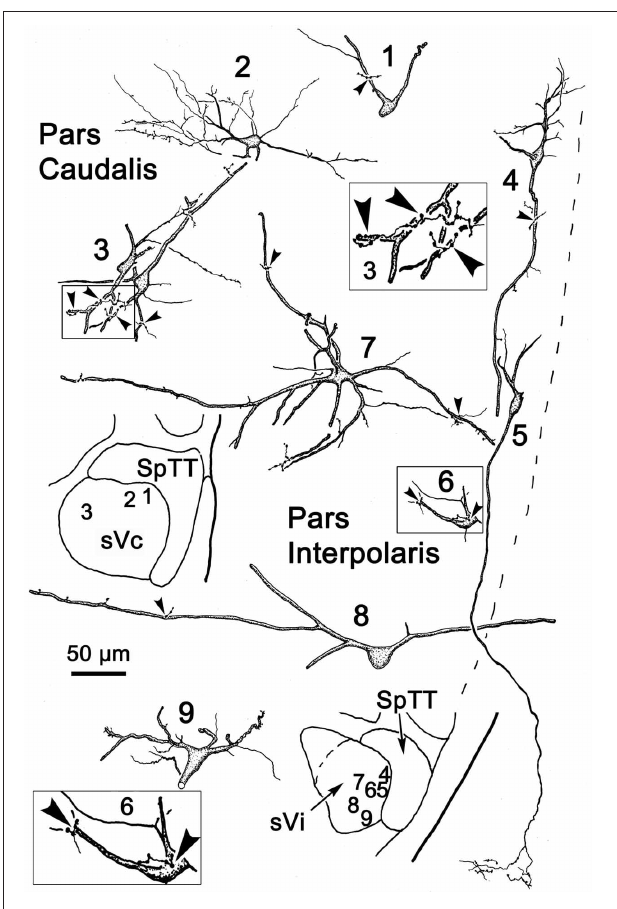
FIGURE 14 | Following the injection illustrated in Figure 13A, labeled neurons and axon terminals were seen contralaterally in sVc (top) and sVi (bottom). Cells 1–3 were located in sVc, as shown in the upper low magnification insert. Close associations (arrowheads) with labeled axonal boutons are shown in the higher magnification box for Cell 3. Cells 4–9 were located in sVi, as shown in the lower low magnification insert. Labeled axon terminals formed close associations with some cells, as shown by the high magnification box for Cell 6.